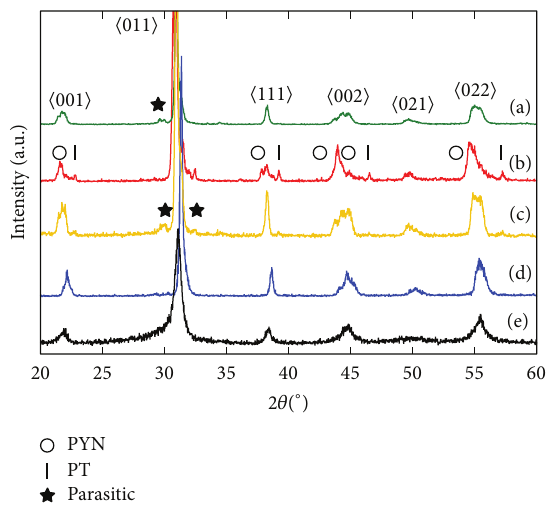
Figure 1: X-ray diagram of PYN-PT powder (for 𝑥 = 60 %) obtained by various techniques: at 950 ∘ C by solid-state reaction of PbO + TiO 2 + YbNbO 4 (a) for 7 h and (b) for shorter calcination time (4h) revealing the presence of PYN and PT and (c) by solid-state reaction of Pb(Yb 1/2 Nb 1/2 )O 3 + PbTiO 3 leading to PYN-PT after 4 h. Pure PYN-PT can be synthesized by solid-state reaction at 800 ∘ C for 12h (d) as well as by mechanosynthesis (e) of PbO + TiO 2 + YbNbO 4